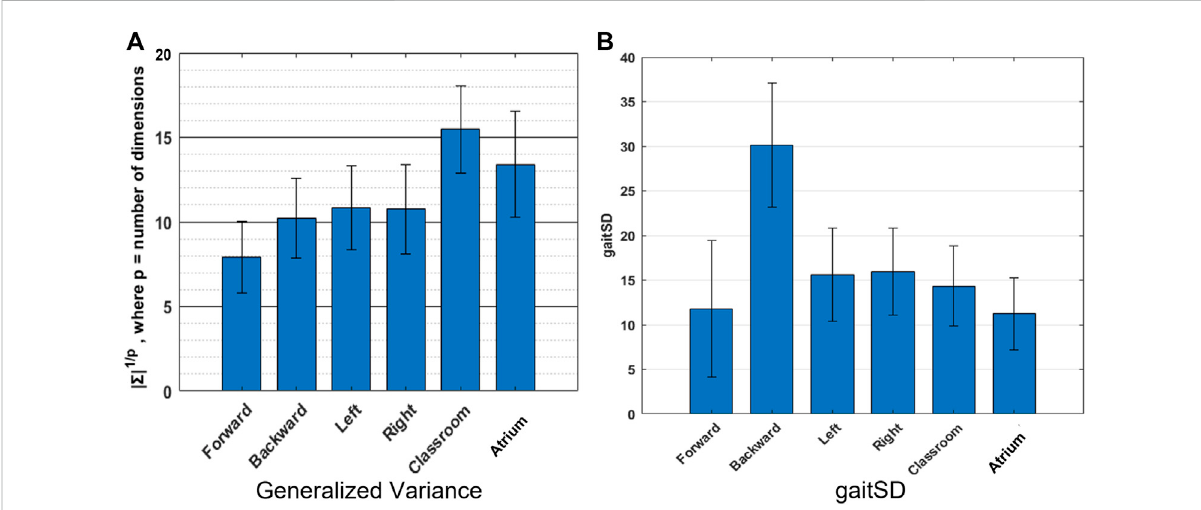
FIGURE 6 Variability: We use two different measures of variability- (A) Generalized Variance (geometric mean of the variances along the Principal Components) which measures the spread of the multi-dimensional data. Walking in classroom exhibits greater complexity in the joint angles, than other activties according to this metric, (B) GaitSD which measures variability of gait kinematics across strides, ranks backward walking to be of greatest complexities. The values reported are inter-subject mean and standard deviation.